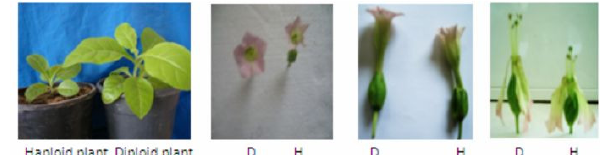
Fig. 5b. The effect of gamma irradiation on